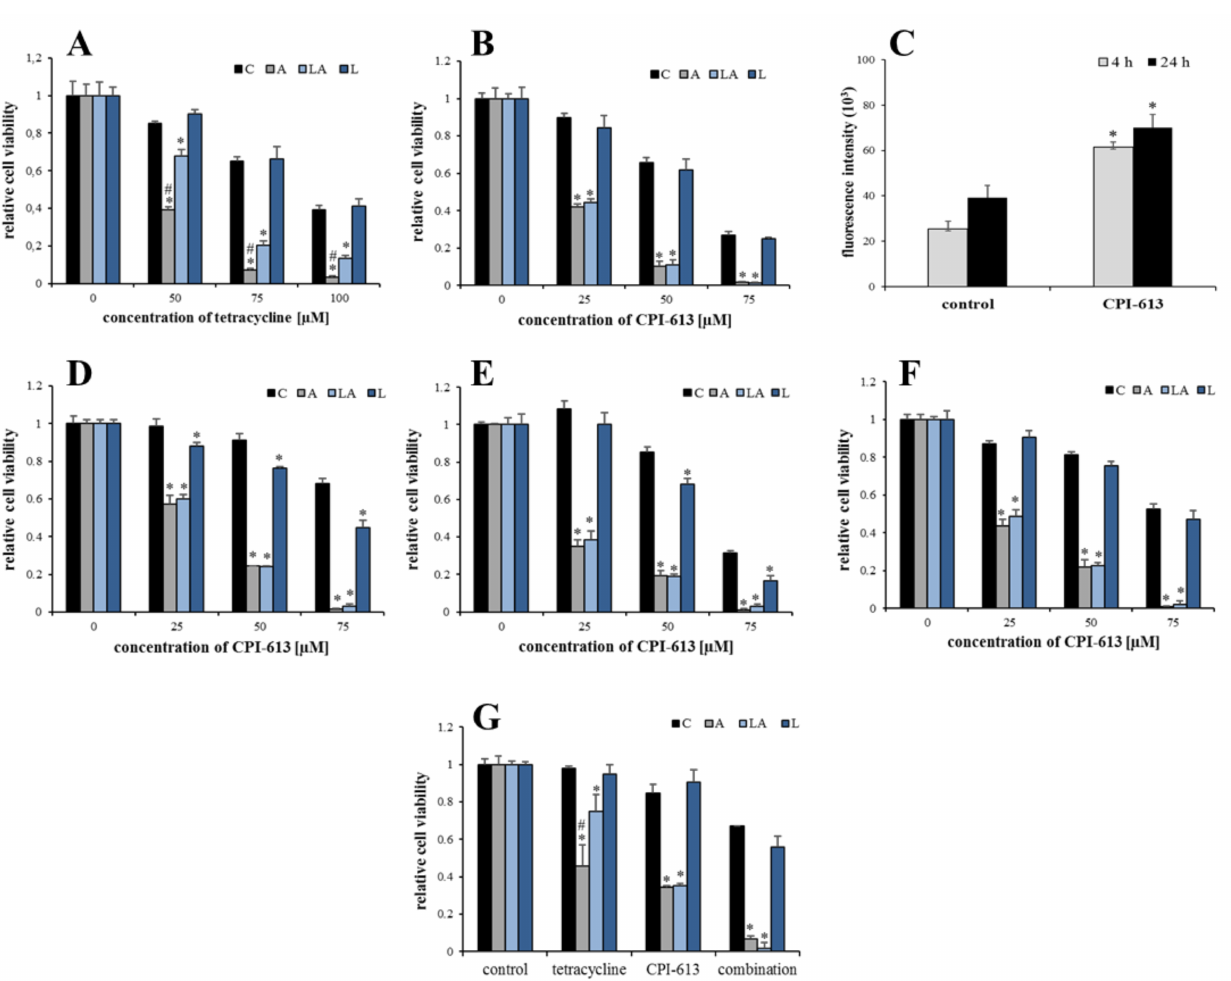
Figure 9. Inhibition of mitochondrial metabolism. PaTu-8902 cells were treated with the experimental media containing the indicated amount of ( A ) tetracycline or ( B ) CPI-613 for 72 h, and the viability was measured. ( C ) Oxidation of 2 (cid:48) ,7 (cid:48) - dichlorodihydrofluorescein was measured as a relative fluorescence in PaTu-8902 treated with 50 µ M CPI-613 for 4 and 24 h. ( D ) HeLa, ( E ) HepG2, and ( F ) HDF cells were treated with the experimental media containing the indicated amount of CPI-613 for 72 h, and the viability was measured. ( G ) PaTu-8902 cells were treated with experimental media containing 50 µ M CPI-613, 50 µ M tetracycline, or their combination for 2 weeks, and the viability was measured by resazurin assay. C, control; A, acidosis; LA, lactic acidosis; L, high lactate (* p < 0.05 compared to C, # p < 0.05 when comparing A and